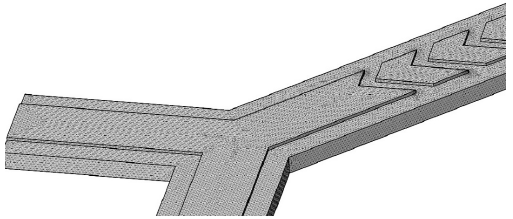
Figure A2. Mesh configuration of the domain at the Y-junction.